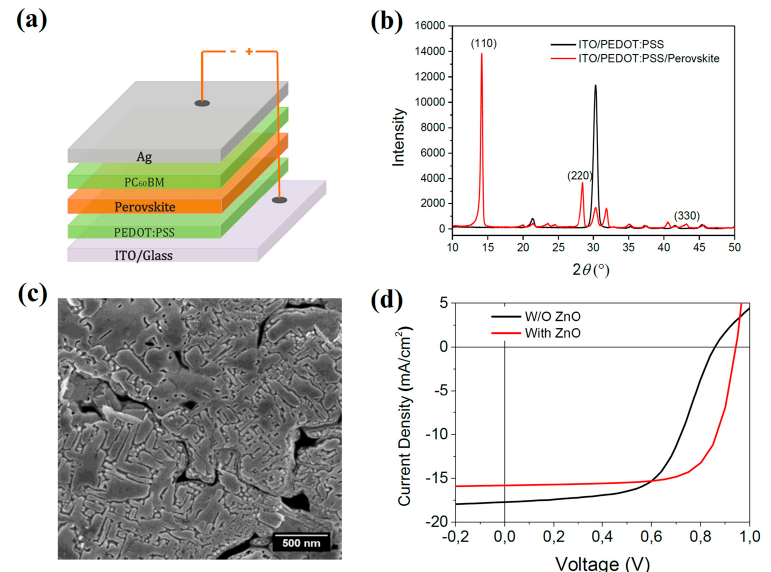
Figure 10. ( a ) The perovskite reference device’s schematic architecture. ( b ) Perovskite crystals grown on PEDOT:PSS/ITO are shown in the XRD pattern (red line), and a control sample of the PEDOT:PSS-coated ITO substrate is shown for comparison (black line). ( c ) Top-view SEM image of the perovskite film in its growing state. ( d ) J-V curves of the two devices with and without a ZnO layer between the PC60BM and Ag top electrode [129].